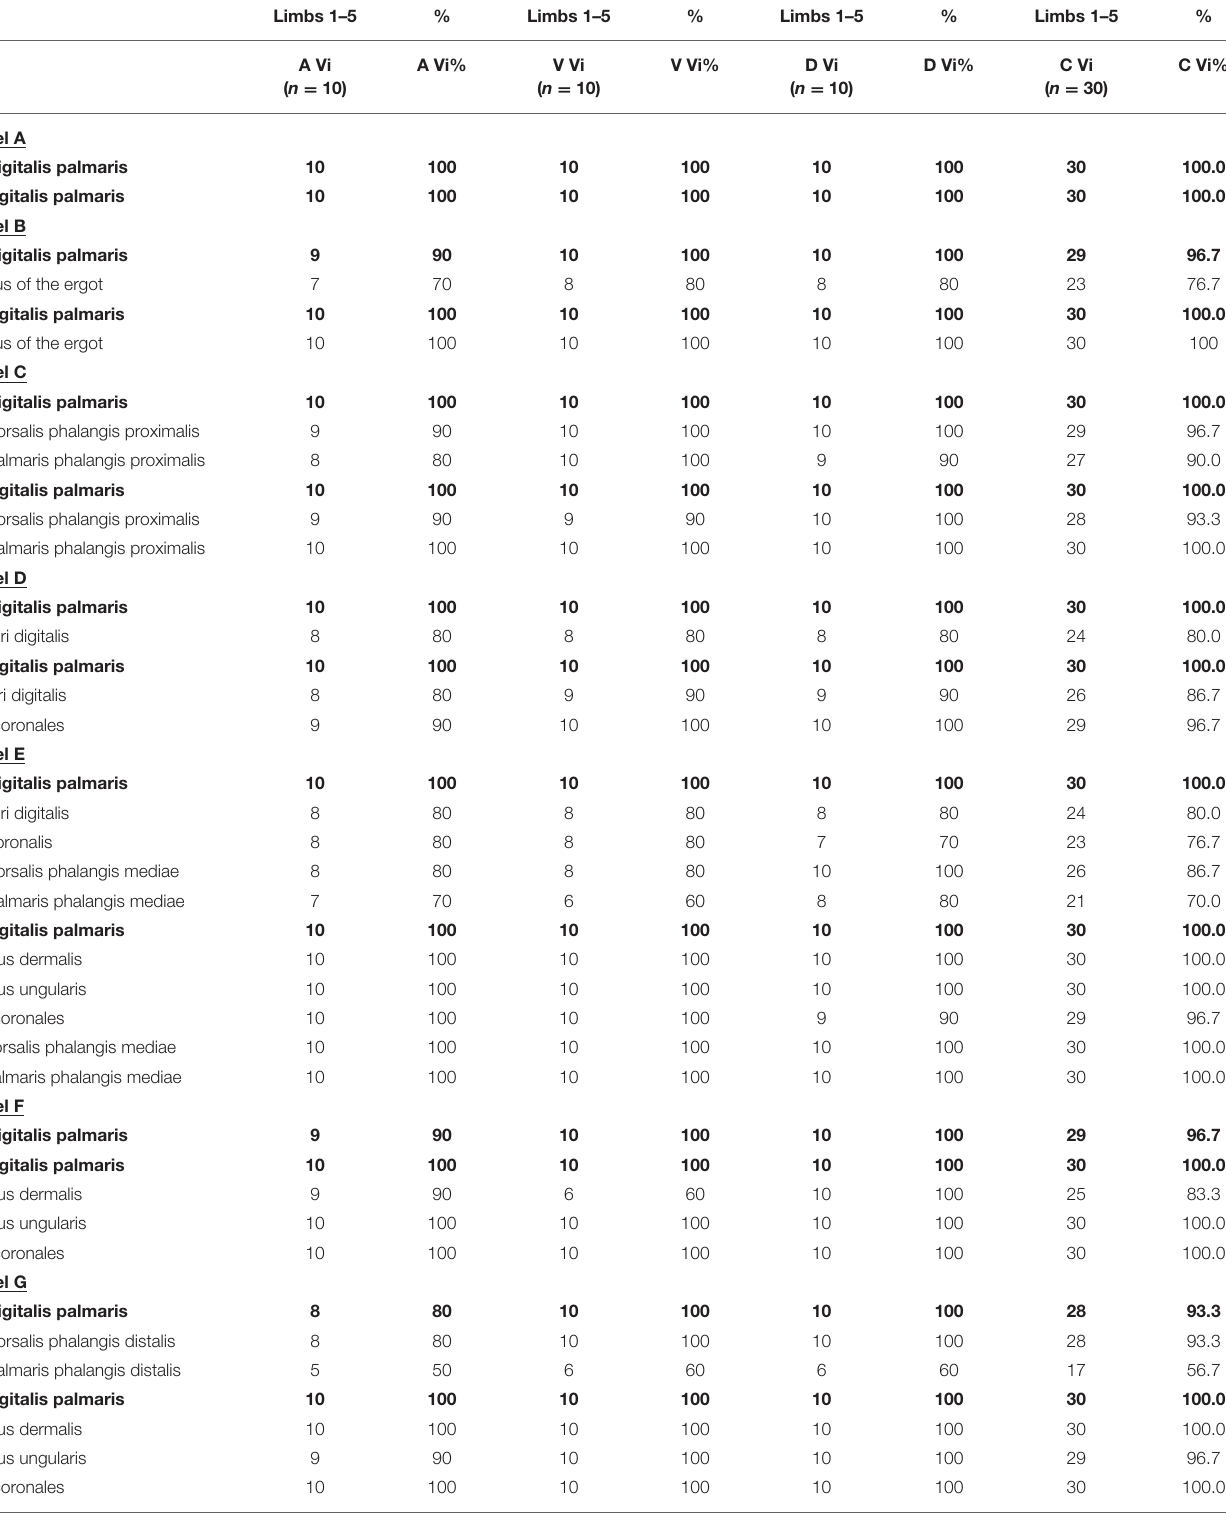
TABLE 2 | Comparison of vascular visualization at every level for all limbs perfused with lipophilic contrast combined, both per phase and for all phases